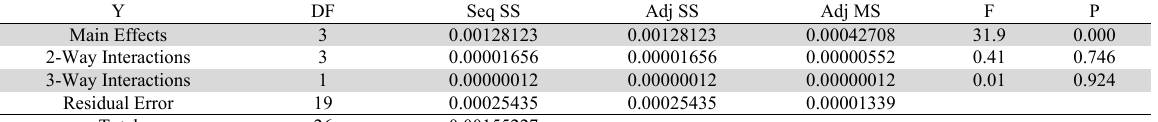
Variance analysis for the environmental cost Y